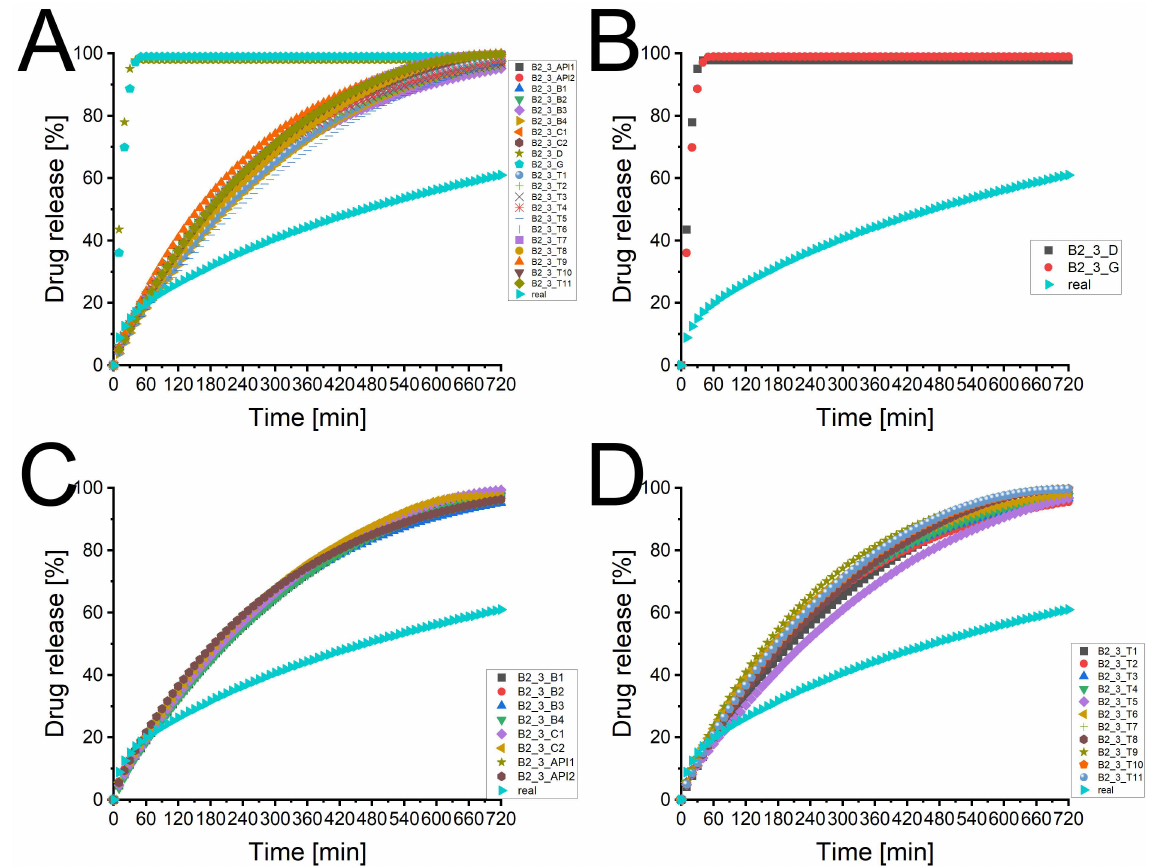
Figure 5. The predicted dissolution profiles of different image processing pathways of the imaged tablet 3 of batch T50E50 ( n = 1). The experimental determined dissolution profile is depicted as well. ( A ) Overview of all dissolution profiles of the imaged tablet 3 of batch T50E50. CAVE: only the symbol and colour of the experimental curve remains always the same. ( B ) Comparison of experimental dissolution profile and both types of virtual tablets produced by the PAC-module. ( C ) Comparison of experimental dissolution profile and virtual tablets based on X µ CT images (API-, combination-, and batch specific pathways). ( D ) Comparison of experimental dissolution profile and virtual tablets based on X µ CT images (tablet specific pathways).